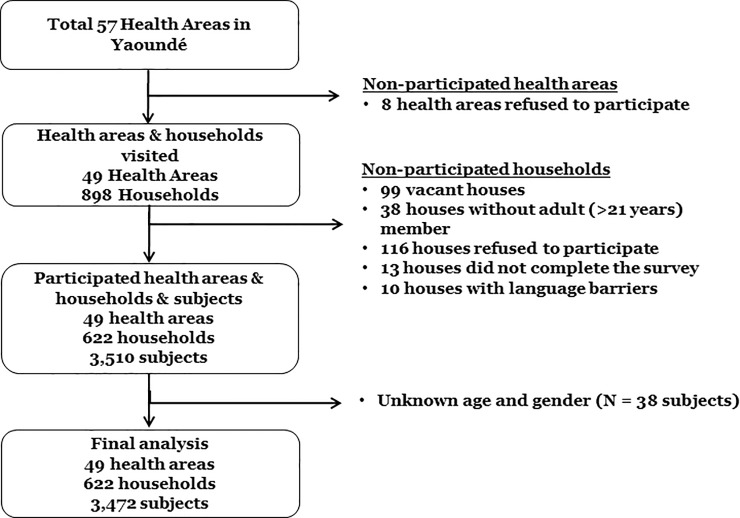
Flow diagram of the study participants in 2017 survey.